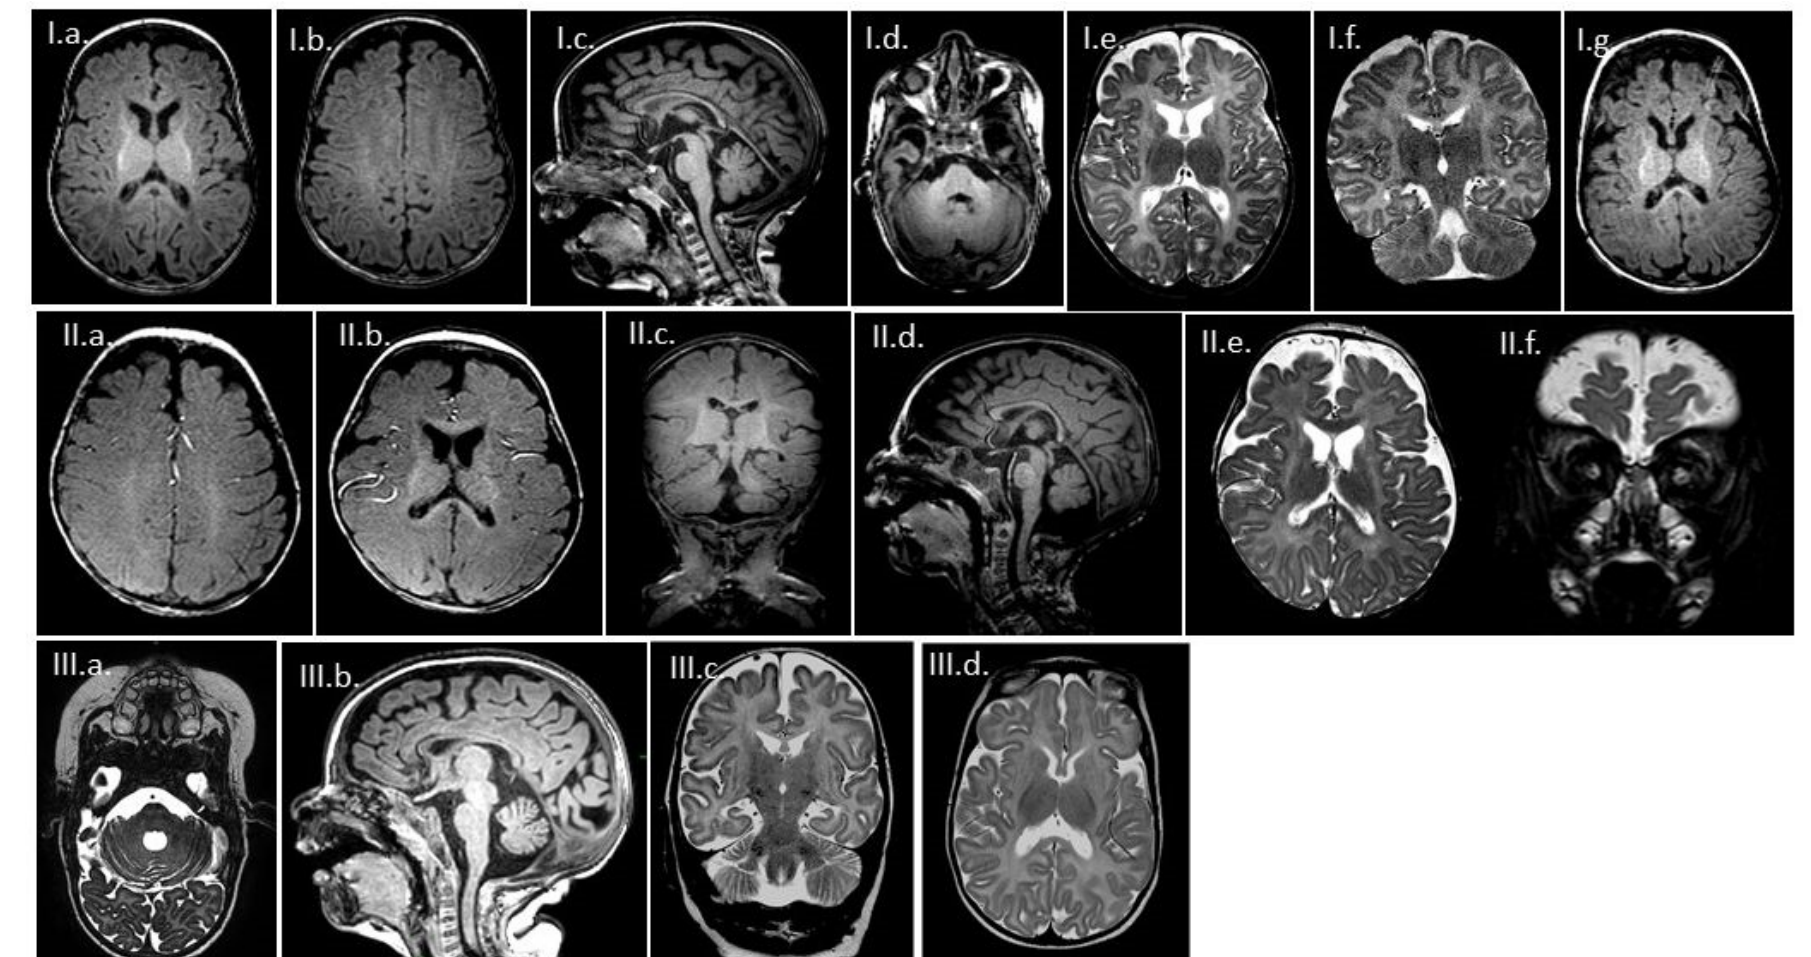
Figure 1. Brain MRI images of Patients 1, 2, and 4. Patient 1: T1 weighted ( I.a – d ) and T2 weighted ( I.e , f ) images at the age of 5 months and 8 months ( I.g ) on T1 sequence; Patient 2: T1 ( II.a – d ) and T2 ( II.e , f ) weighted images at 8 months of age; Patient 4: T2 weighted axial image at 4 months of age ( III.a ), T1 sagittal image ( III.b ), T2 coronal and axial planes ( III.c , d ).